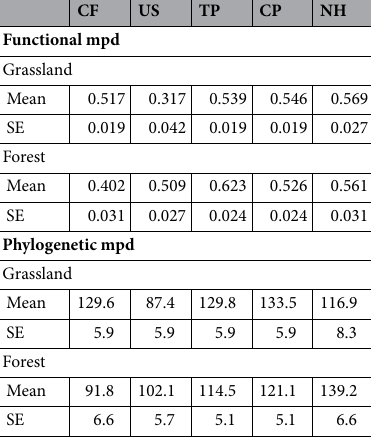
Table 1. Functional and phylogenetic mpd mean and standard error (SE) values in each habitat type from Grassland and Forest. CF crop fields, US urban settlements, TP tree plantations, CP cattle pastures, NH natural habitats.